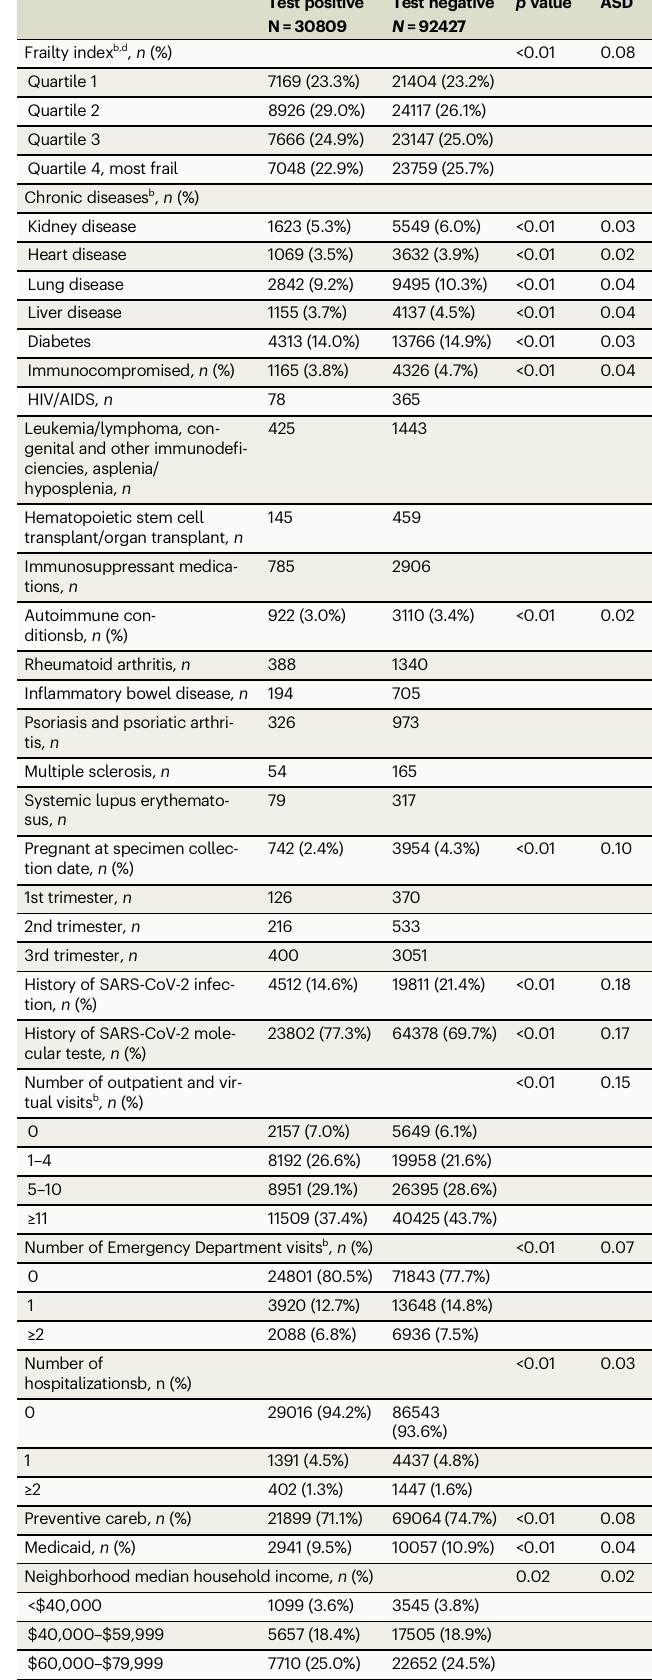
Table 1 | Characteristics of SARS-CoV-2 test-positive cases and test-negative